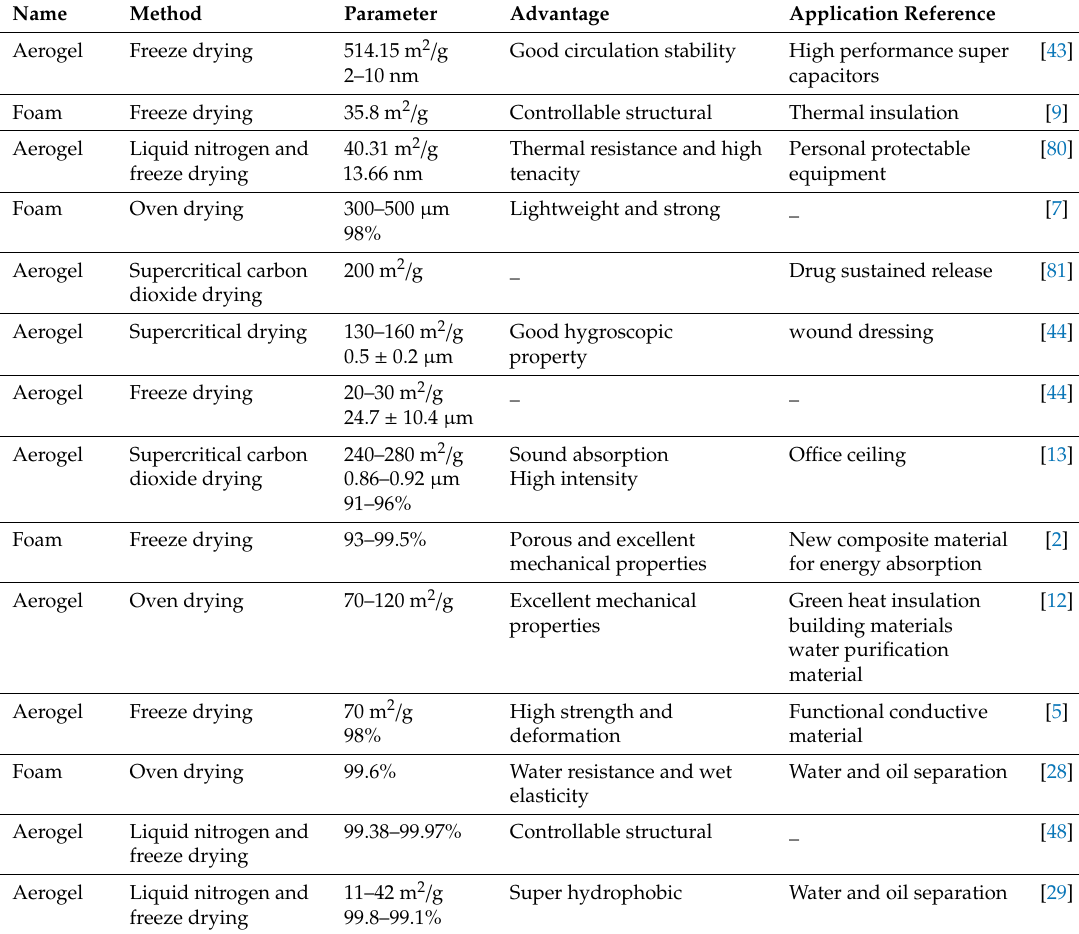
Table 3. Comparing the properties of porous materials prepared by di ff erent drying